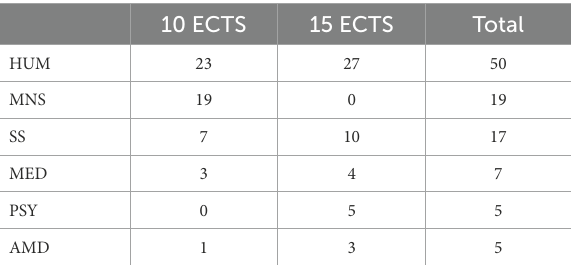
TABLE 1 Frequency of courses by faculty and ECTS credits.